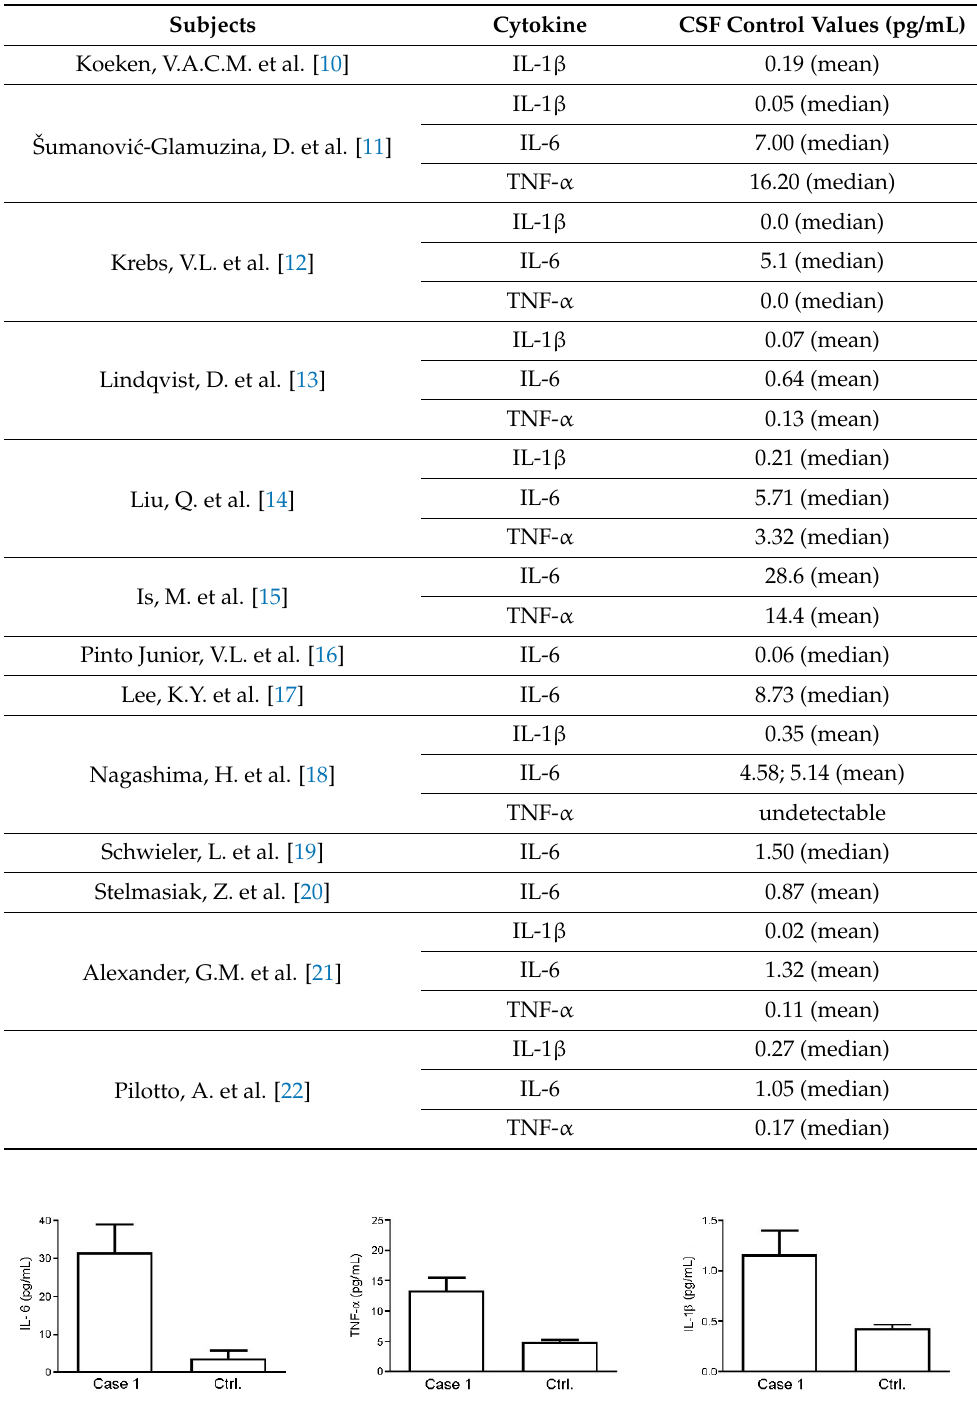
Table 1. Reference values for IL-1 β , IL-6 and TNF- α levels in CSF of control subjects of different studies indicated.